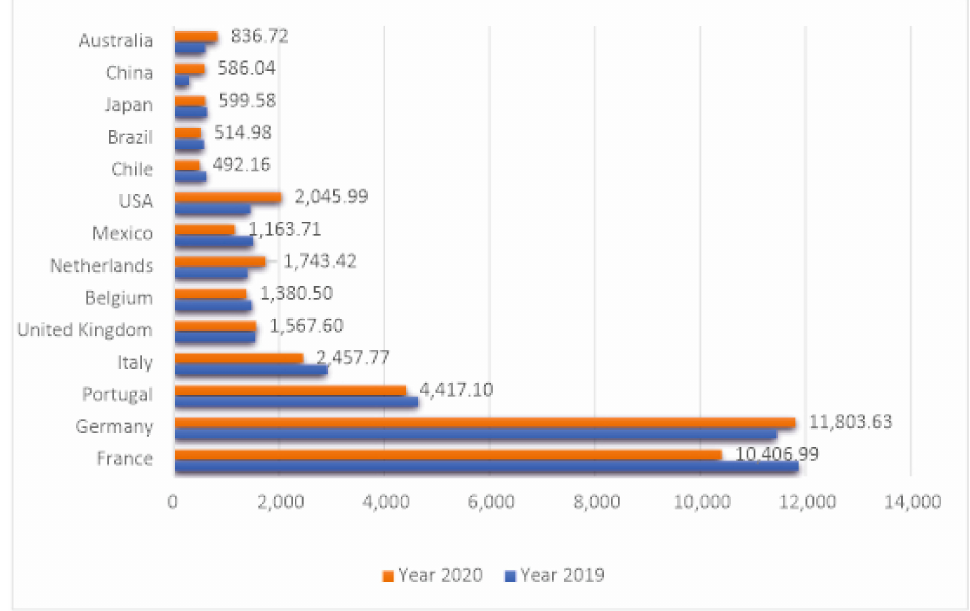
Figure 1. Export of ham (tons). Source: own elaboration based on information from the Ministry of Agriculture, Fisheries, and Food (MAPA) [9].